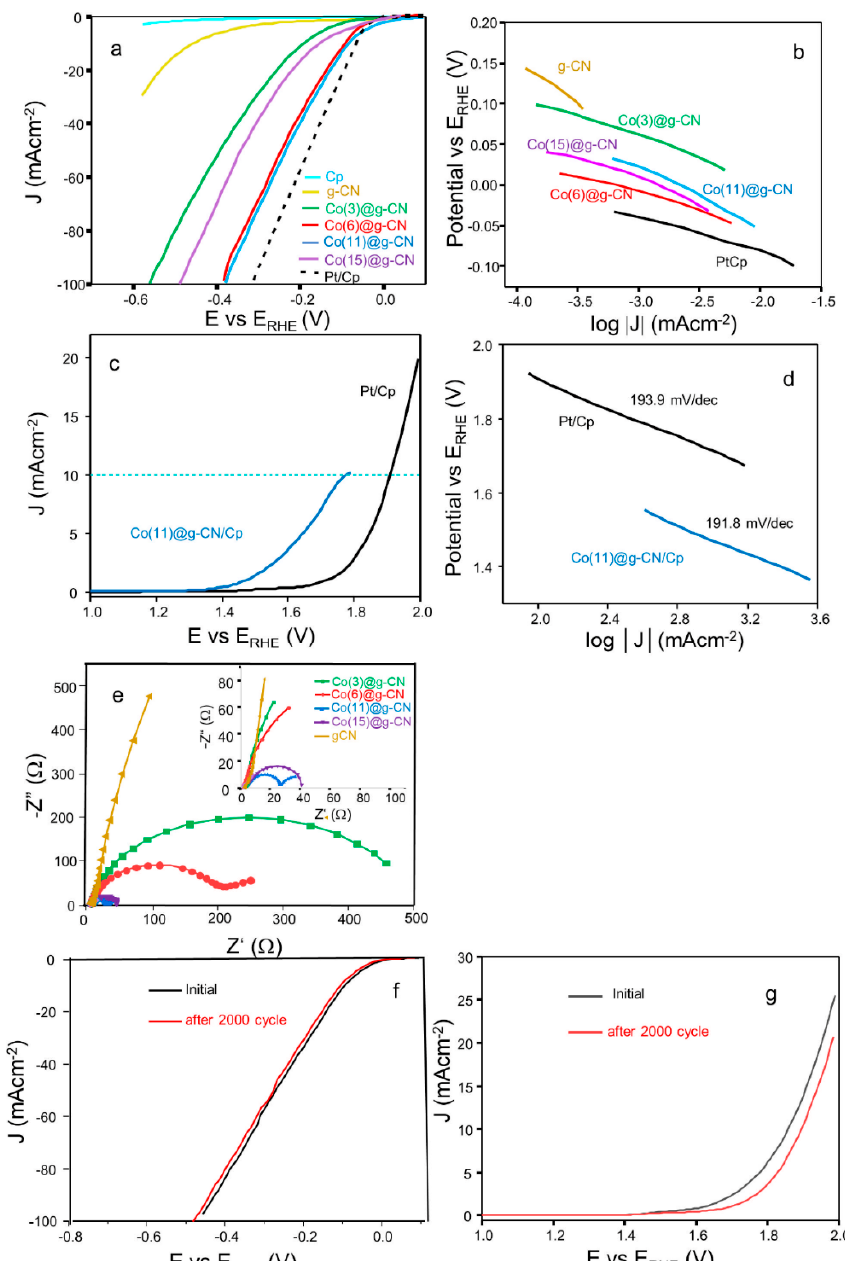
Figure 6. ( a ) LSV of HER activity of catalysts, and ( b ) their corresponding Tafel plots; ( c ) LSV of OER activity of Co(11)@g-CN and Pt/Cp, and ( d ) their corresponding Tafel plot; ( e ) EIS of catalysts with a magnified inset, ( f ) recyclability test of HER, and ( g ) recyclability test of OER on Co(11)@g-CN after 2000 cycles.